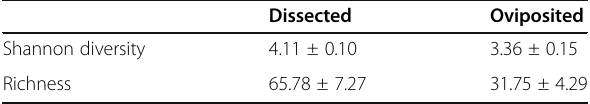
Table 2 Effect of shipping on cloacal microbiome of S. virgatus females Test statistic df p Shannon diversity